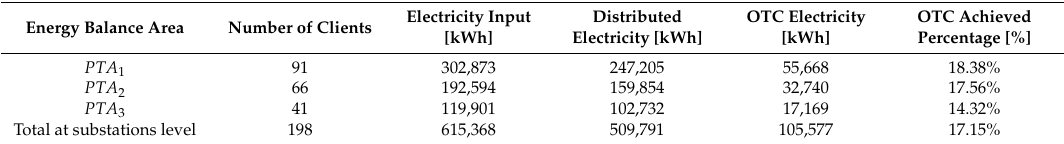
Table 2. The 2019 energy balance for the considered investigated area.